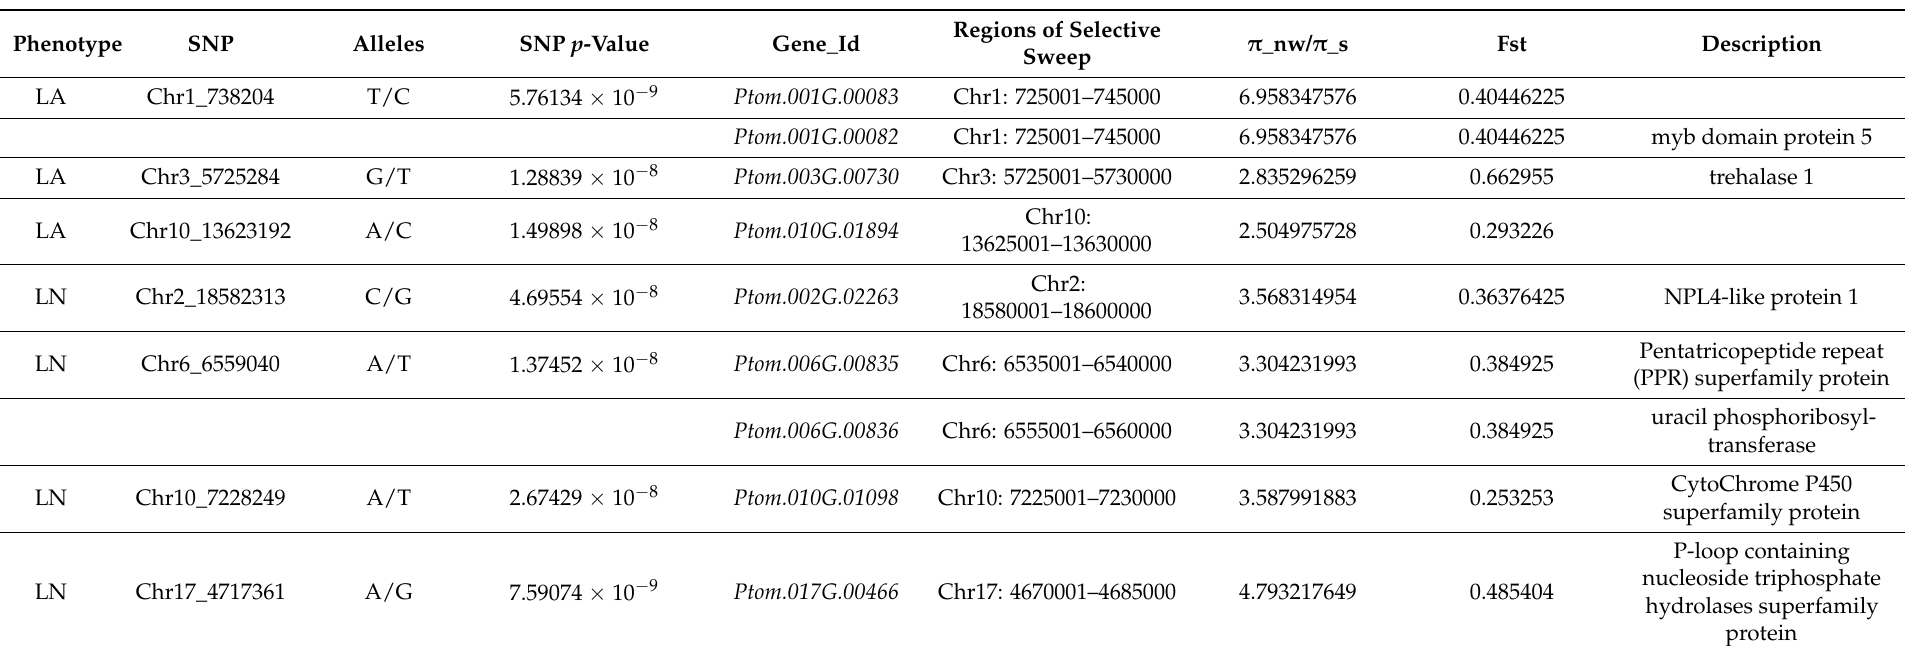
Table 1. Full details of genes harboring significantly associated single nucleotide polymorphisms (SNPs) and overlapping the genomic regions of adaptive